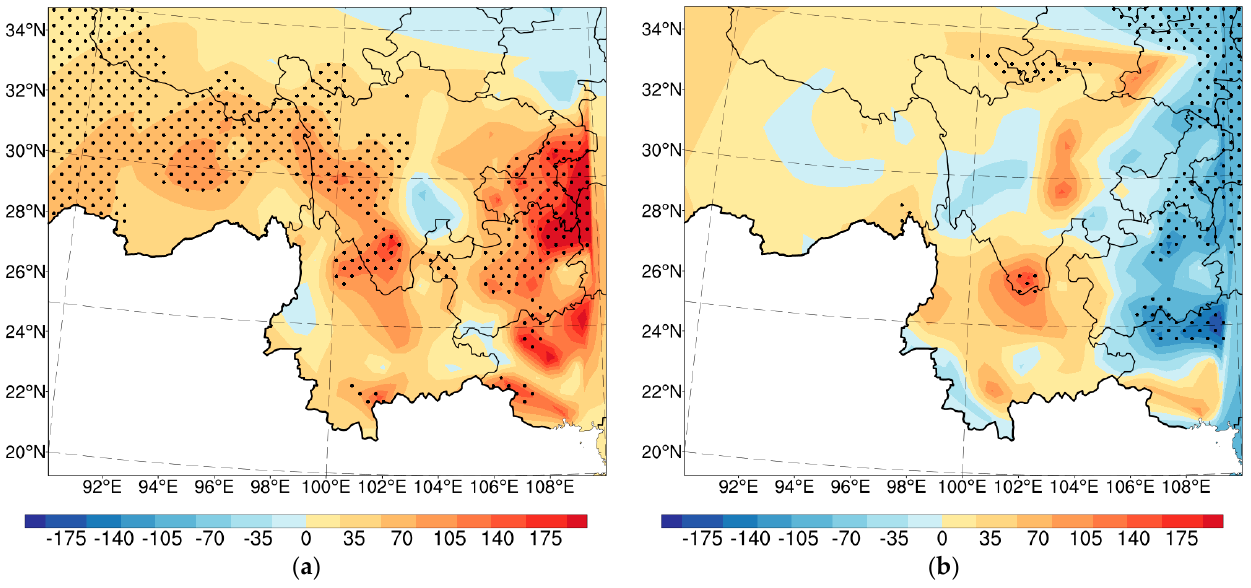
Figure 7. Spatial distribution of precipitation anomalies over southeast China under strong ( a ) and weak ( b ) monsoon surges. (Unit: millimeters, mm; dotted area passes 95% significance